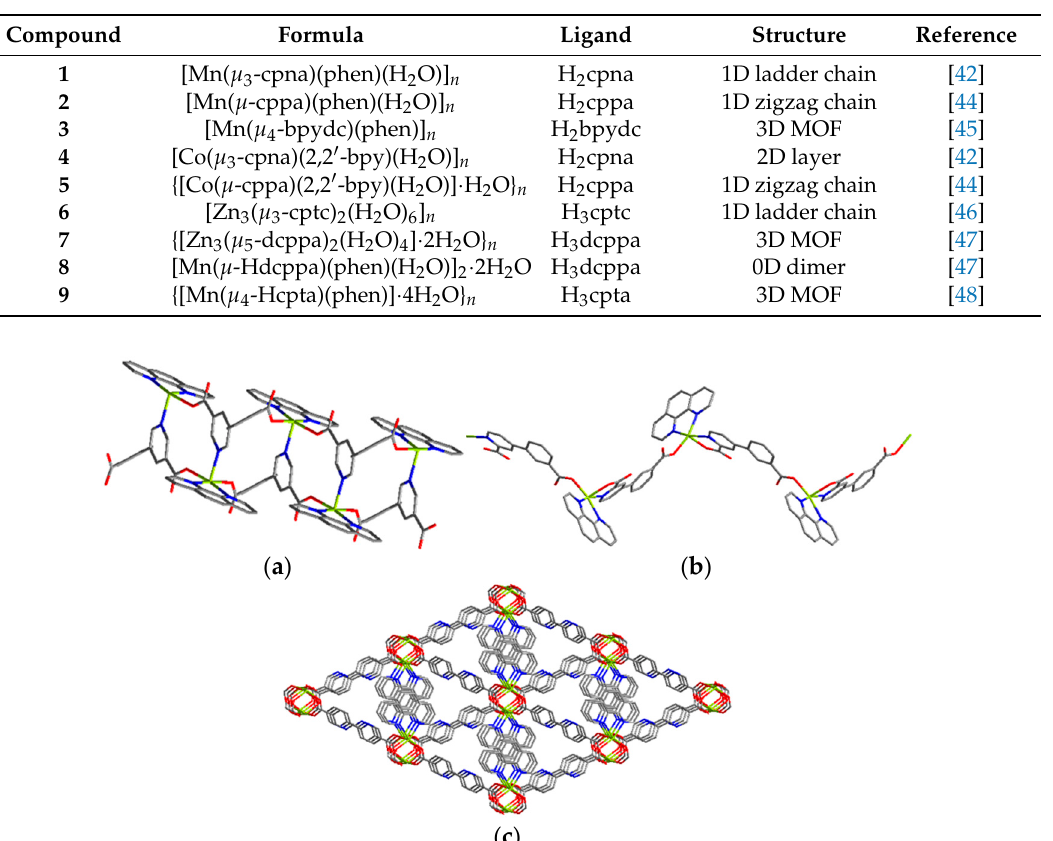
Table 1. Selected examples of coordination polymers (CPs) showing an effect of main carboxylate ligand on product structure.